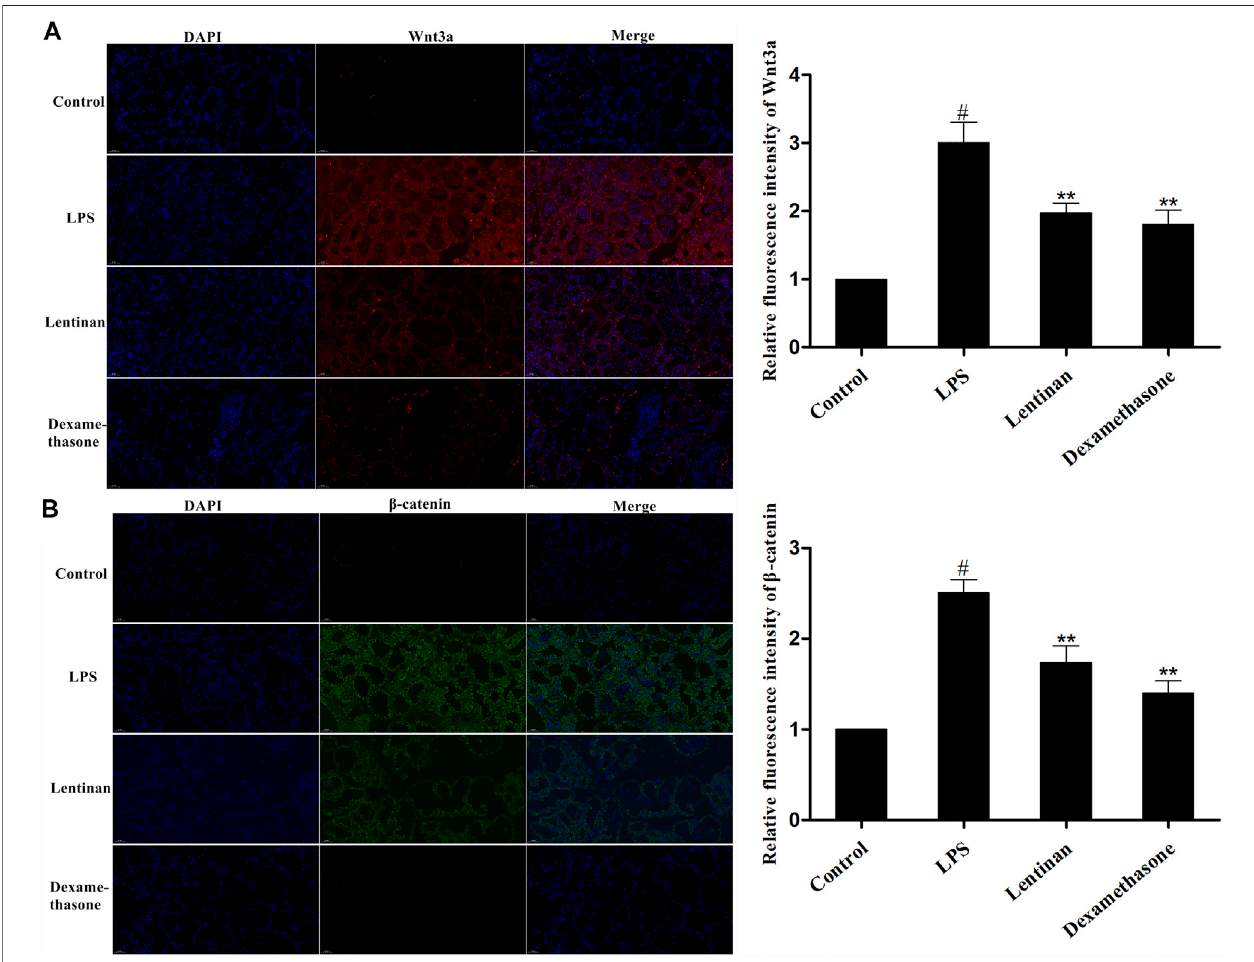
FIGURE 4 | Effects of lentinan on the activation of the Wnt/ β -catenin pathway. The activation of the Wnt/ β -catenin pathway in LPS-stimulated mouse mastitis was determined by immuno fl uorescence assay. All data are represented as the mean ± S.E.M. of three replicates.